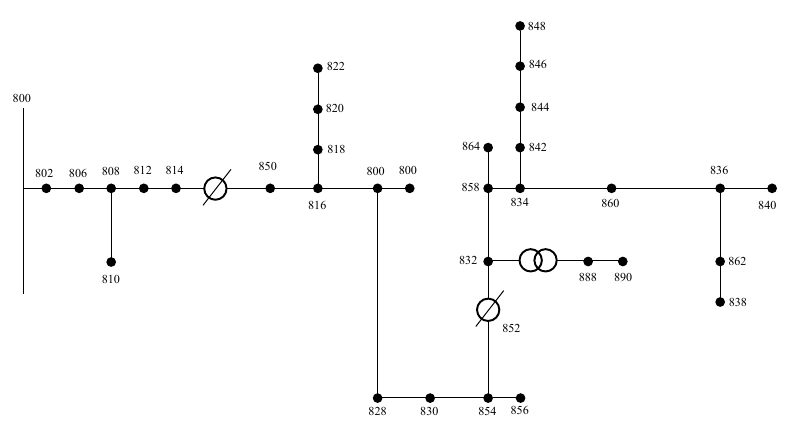
Figure 9. One-line diagram of the standard IEEE 34 feeder system.